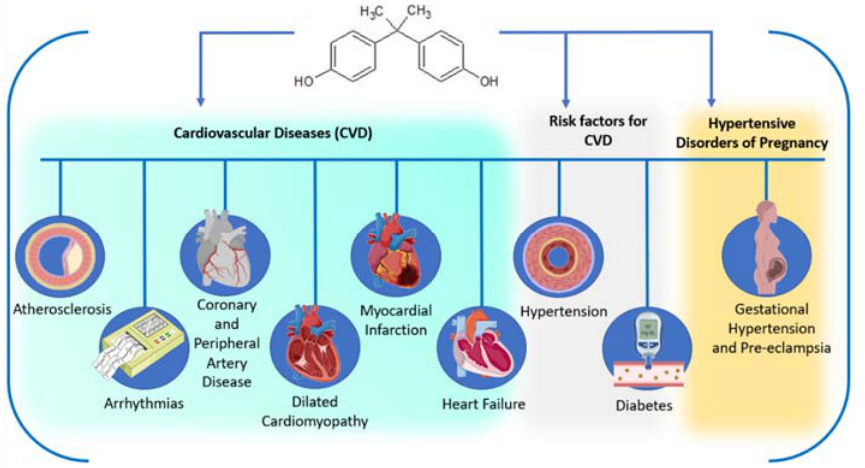
Figure 2. Summary representation of the endocrine-disrupting effects of bisphenol A on the cardiovascular system.